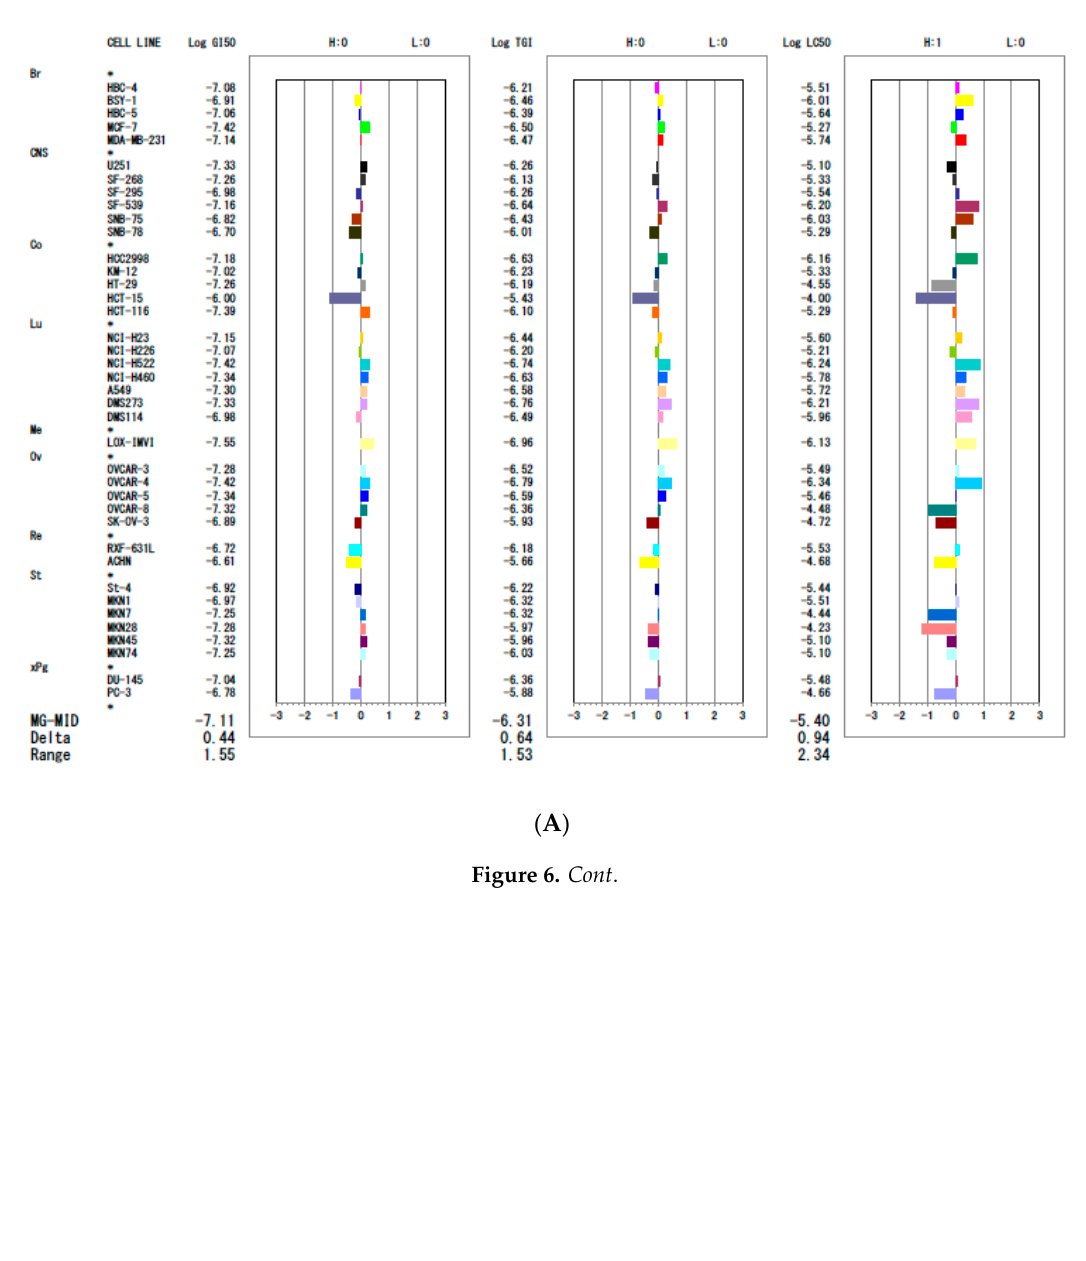
Figure 5. Structure of tacrine-neocryptolepine hybrids.